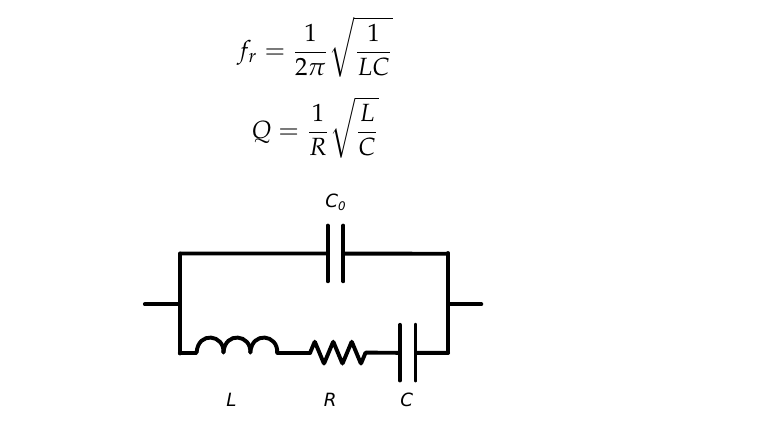
Figure 2. Second order RLC MEMS model used to fit the